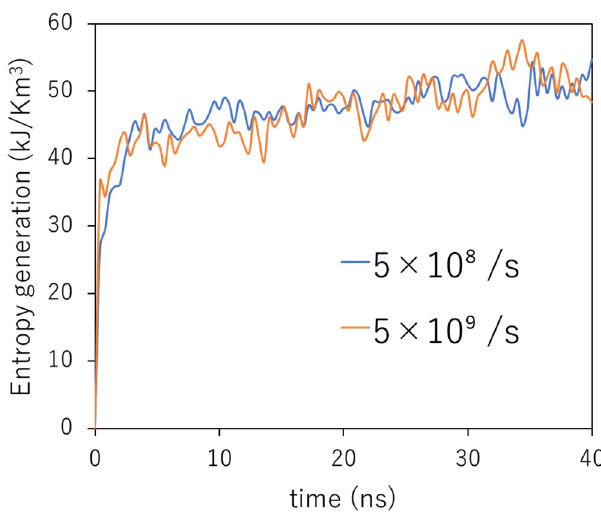
Figure 6. Time development of the entropy generation under a cyclic loading with different strain rates.